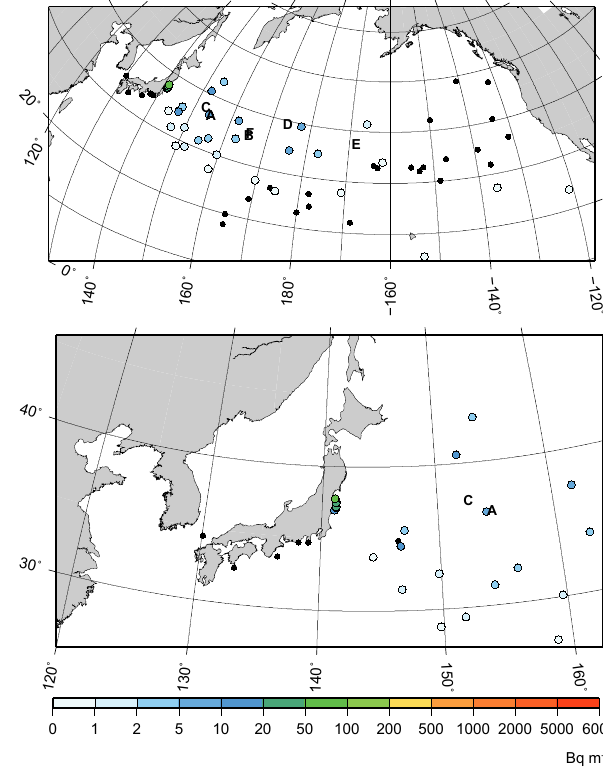
Fig. 3. 134 Cs activity in the surface water during the period from October 2011 to December 2011 for the North Pacific Ocean (up- per) and close to Japan (lower). Positions of Argo floats on 15 November 2011 are marked “A–G”.